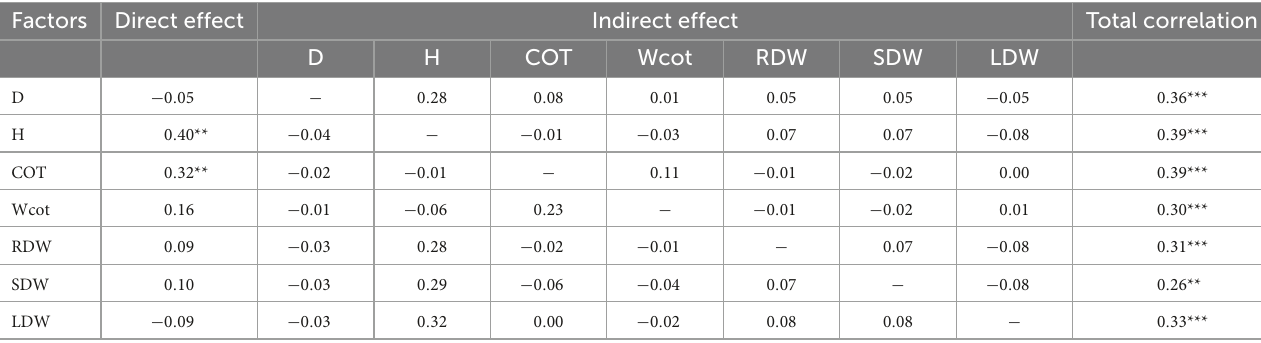
TABLE 4 Path analysis of the relationships between seedling survival in the WS treatment and the various independent variables (growth, biomass and cotyledons).